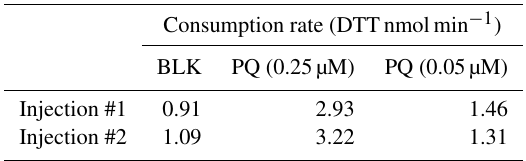
Table 1. DTT consumption rate (nmolmin − 1 ) for consecutive sam- ples of different activities.